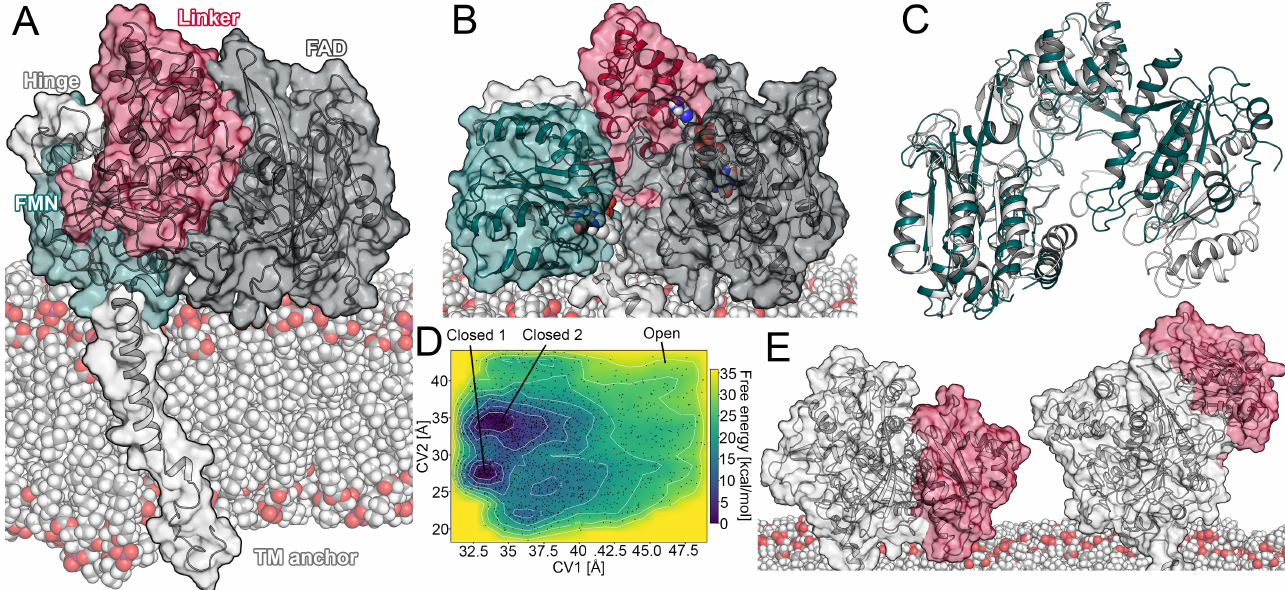
Figure 1. Conformational changes in the CPR. ( A ) Domains of the CPR. ( B ) Open conformation of the CPR obtained from well-tempered metadynamics simulation. Domain coloring was retained from ( A ). ( C ) Superposition of the aforementioned open conformation of the CPR and the open conformation of the rat CPR (PDB ID: 3WKT). ( D ) Free energy profile of well-tempered metadynamics simulation. ( E ) Sitting and upright position of the CPR (the FAD domain is colored